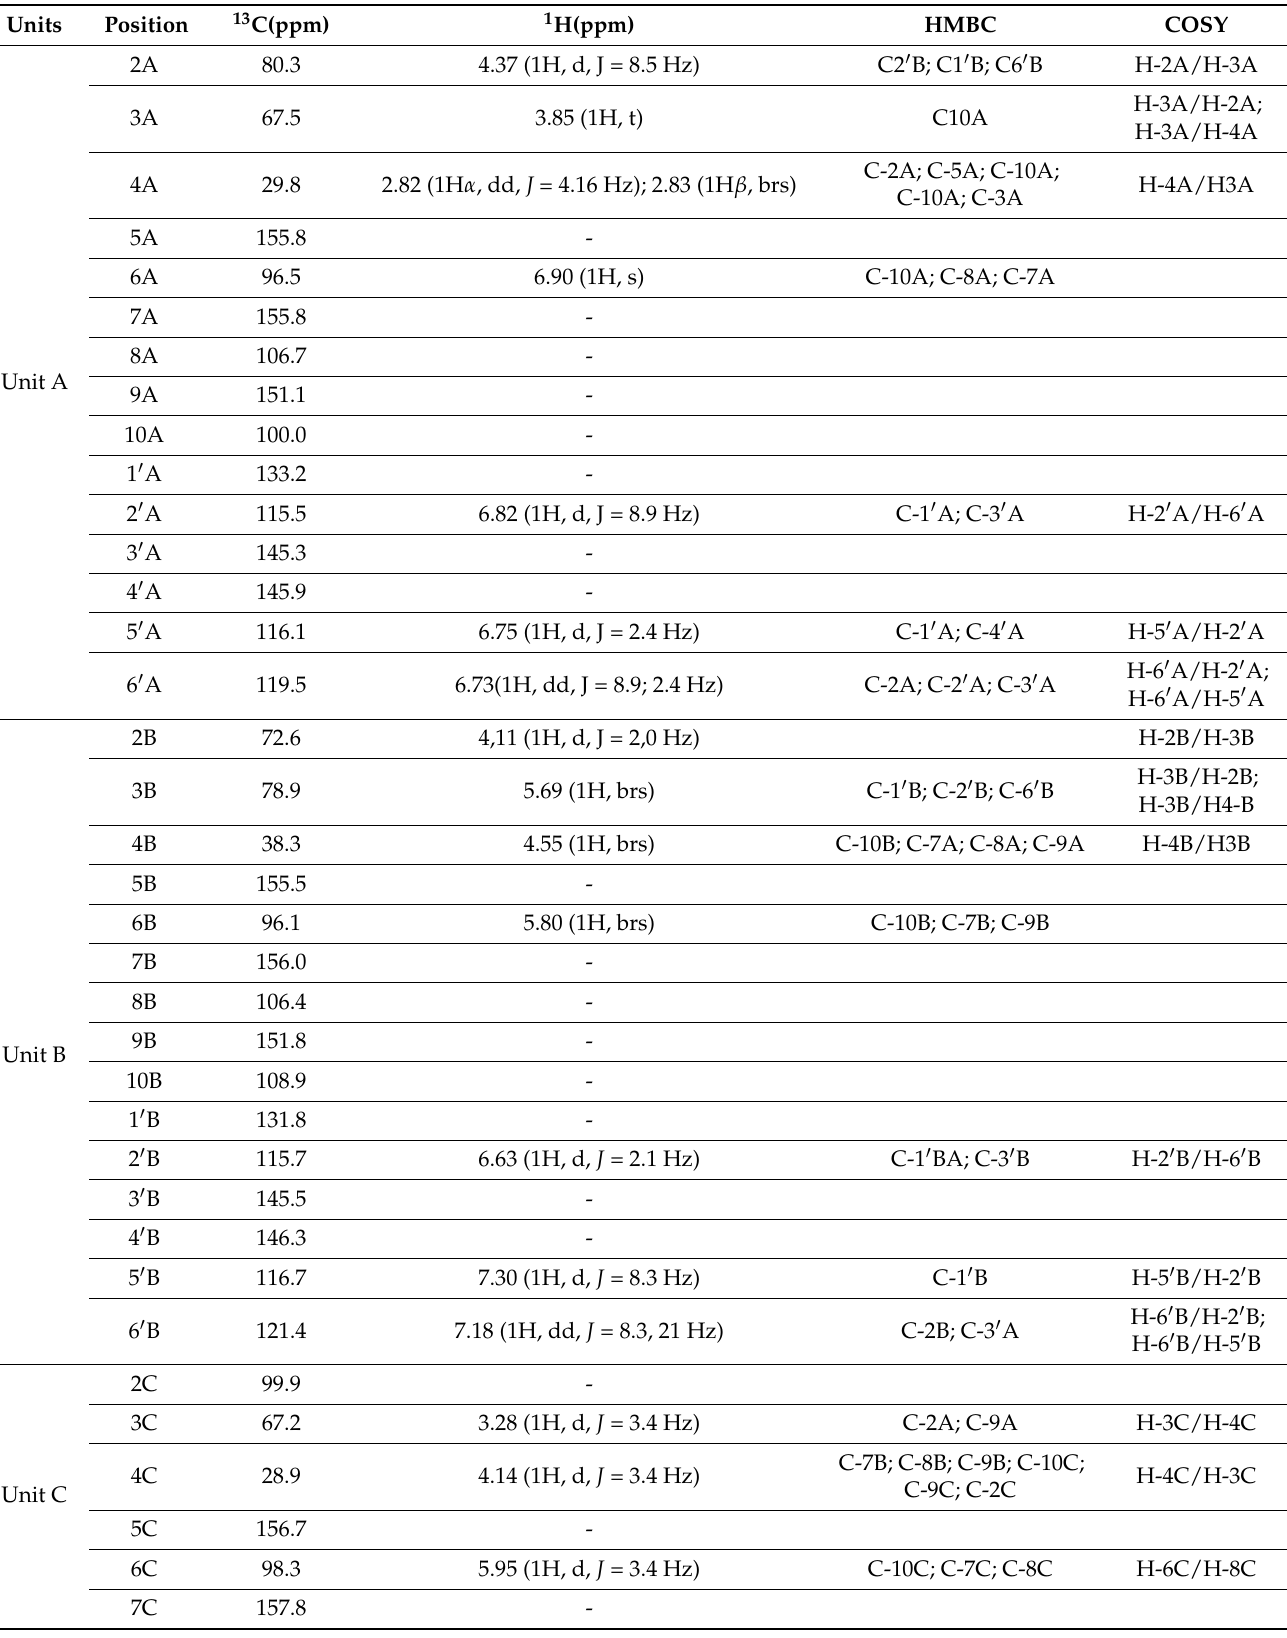
Table 1. Spectral data of compound 1 : 1 H NMR and 13 C NMR with key HMBC and